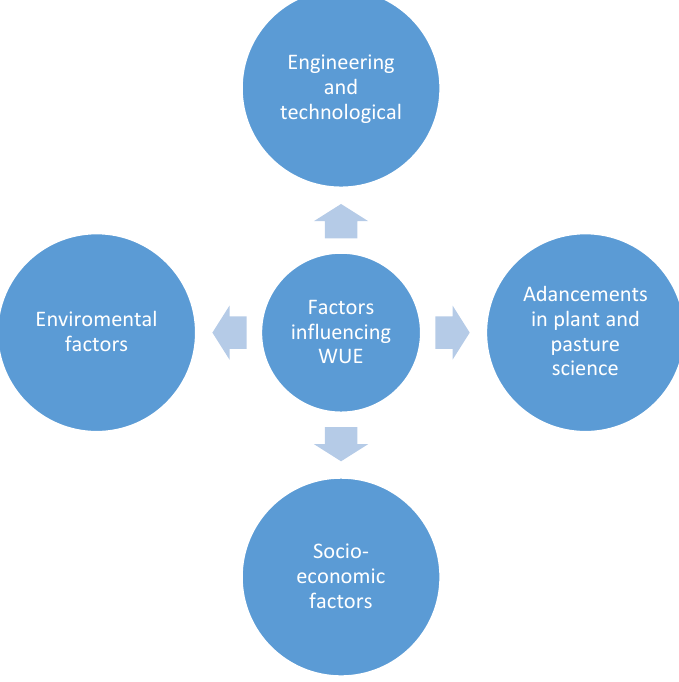
Figure 7. Factors influencing water use efficiency.